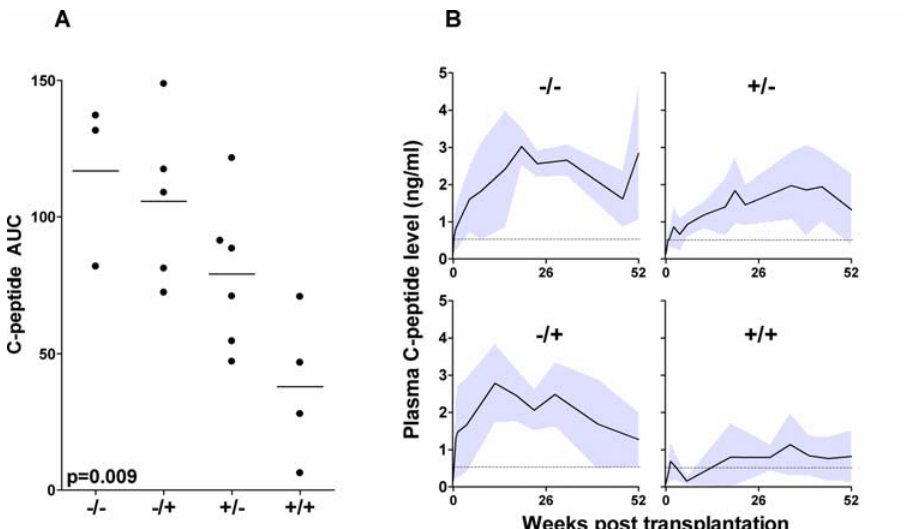
Figure 4. Influence of pre-transplant T cell autoreactivity stratified for total injected b -cell mass. Shown are pre-transplant T cell autoreactivity and achievement of insulin independence for patients receiving more or less than the median total injected b -cell mass (the single patient receiving the median b -cell mass is excluded). Groups are compared by Fischer exact test.